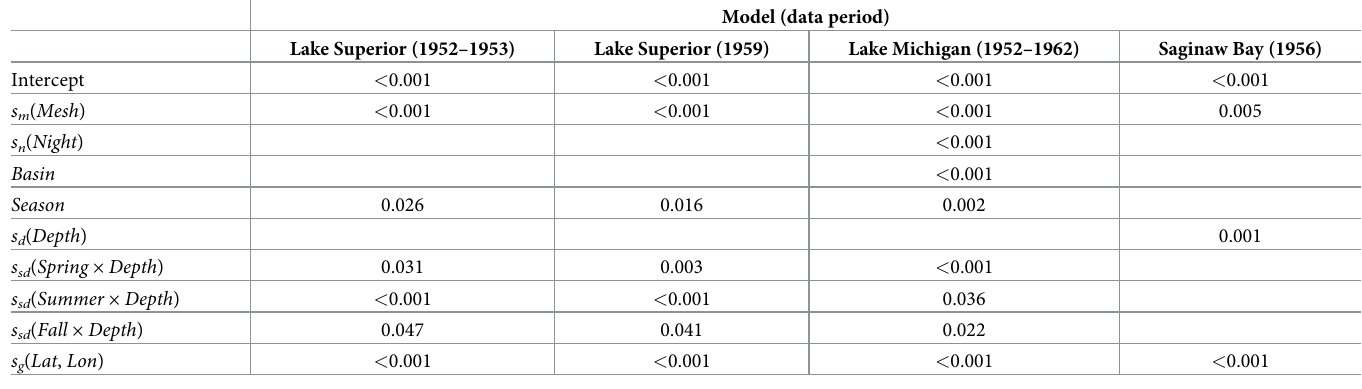
Table 2. The p values of intercepts and selected predictors in the generalized additive models fitted to gill-net